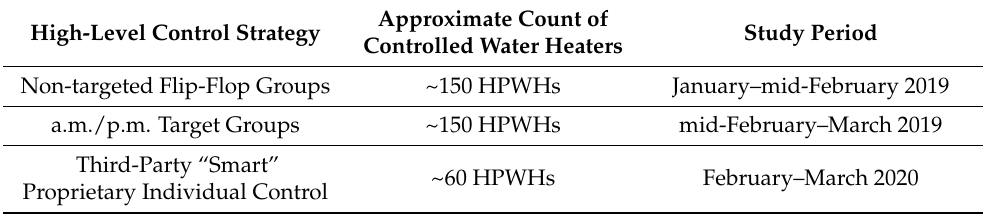
Table 1. Project Phase